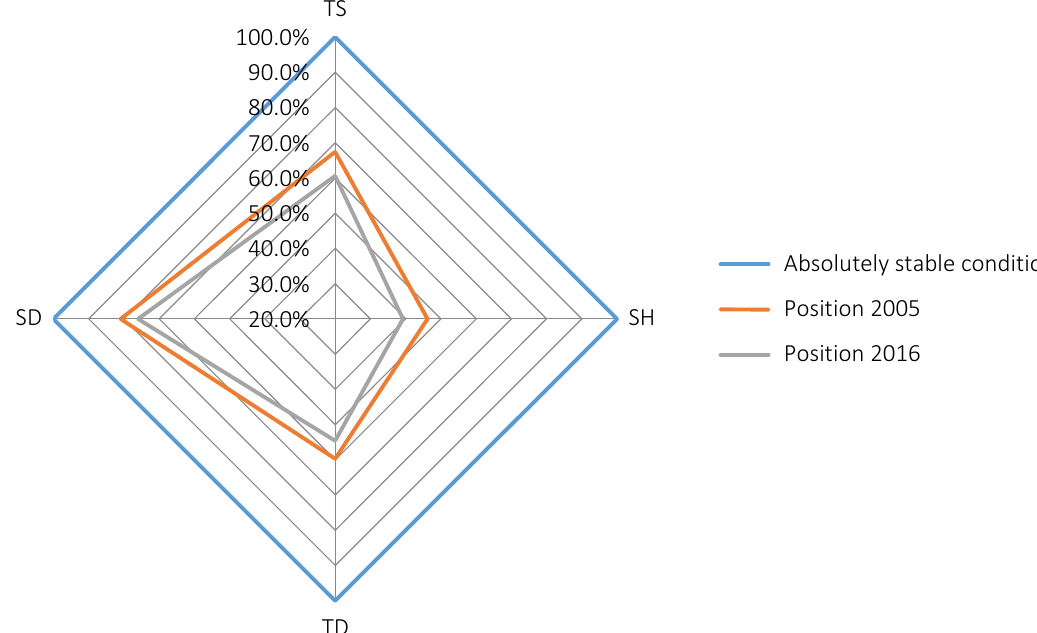
Figure 4. The diagram of the change of the levels of properties expressiveness, which ensure the sustainability of enterprises, for the 2005–2016 period (generalized by the group of